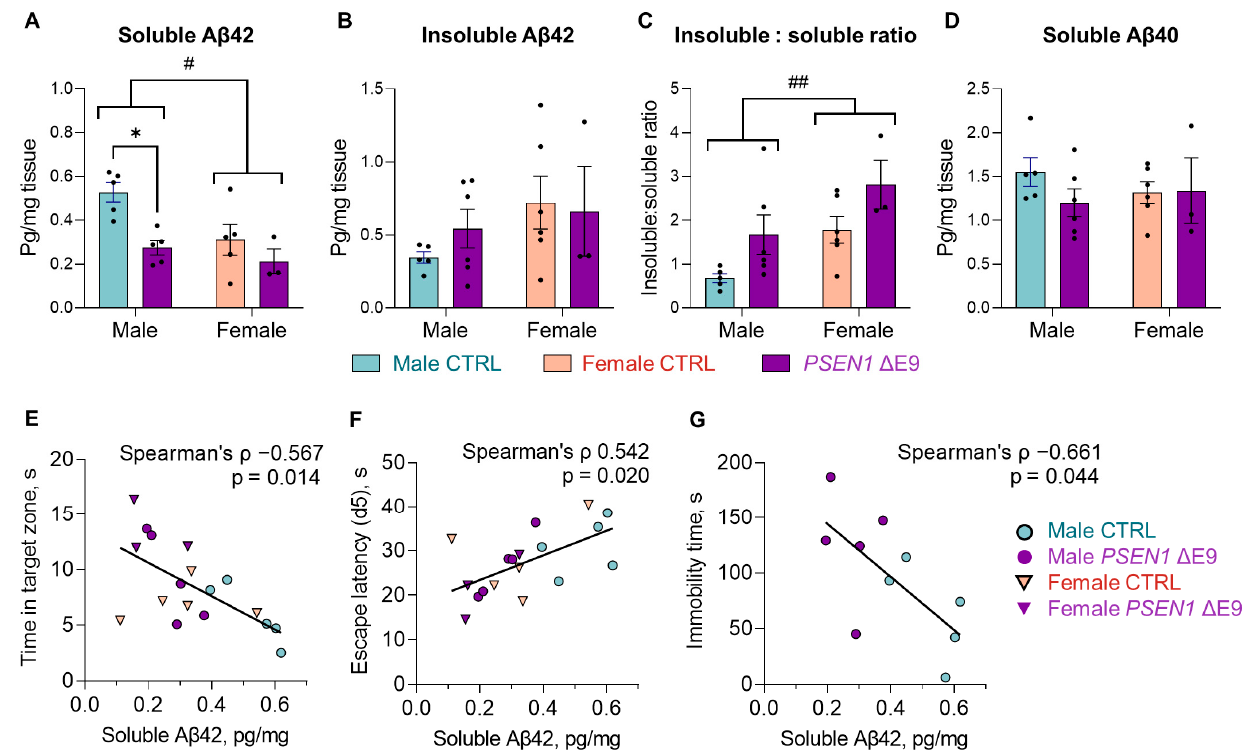
Figure 4. PSEN1 ∆ E9 mutant human cells convert a higher proportion of self-produced A β 42 to insoluble form than the control cells. ( A , B ) The levels of TBS-soluble ( A ) and insoluble (guanidine fraction; ( B ) A β 42 in the cortex expressed as pg/mg tissue. ( C ) The ratio of A β 42 levels in guanidine fraction (insoluble) to TBS fraction (soluble). ( D ) The level of TBS-soluble A β 40 in the cortex expressed as pg/mg tissue. Purple bars indicate PSEN1 ∆ E9 glia-transplanted mice, blue bars indicate CTRL-transplanted males, and salmon CTRL-transplanted females; dots represent values obtained from individual animals. The data in the graphs are shown as mean ± SEM; n = 3–6 per group; * p < 0.05 as compared to sex-matched CTRL; # p < 0.05; ## p < 0.01. ( E – G ) Correlation plots of cortical soluble A β 42 levels (pg/mg) with the time spent in the target zone (s) in the 2nd probe trial of Morris swim task ( E ), escape latency (s) on day 5 of training phase ( F ), and with the immobility time (s) in forced swim task ( G ). In plots E and F, both male and female data are included; in plot G, only the data from